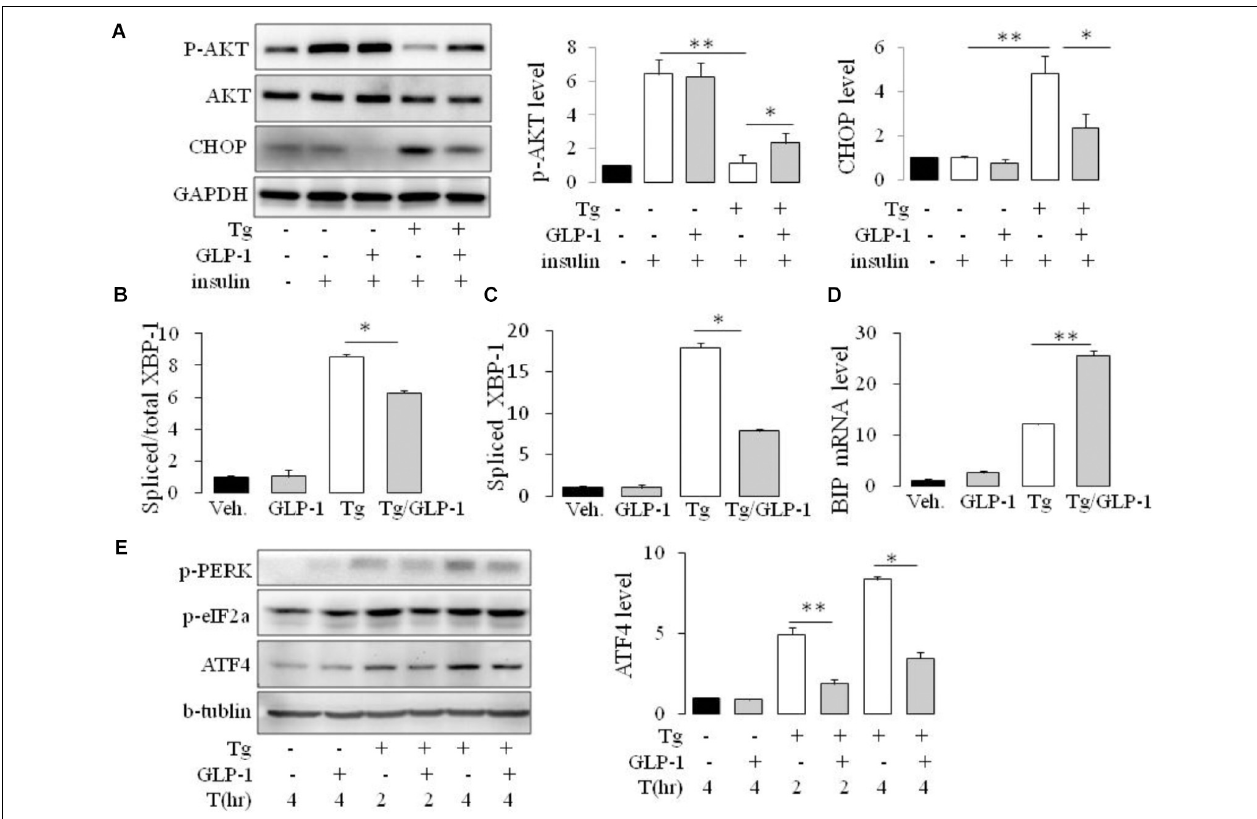
FIGURE 2 | GLP-1 attenuated insulin resistance (IR) and regulated both PERK and IRE1/XBP-1 arm of the UPR in mouse adipose cell line. 3T3-L1 preadipocytes were induced to differentiate into mature adipocytes. (A) The differentiated adipocytes were fasted for 6 h in low-glucose DMEM media with 0.2% BSA (fasting media) and then were treated with vehicle alone or thapsigargin (Tg) in the absence or presence of 50 nM GLP-1 in fasting media for 16 h. The cells were then stimulated with insulin (100 nM) in fasting media for 10 min. (B–D) The differentiated adipocytes were fasted for 16 h in fasting media and then were treated with vehicle alone or thapsigargin (Tg) in the absence or presence of 50 nM GLP-1 in fating media for 9 h (B–D) or for 2–4 h (E) . Three wells of cell extracts were pooled together and were analyzed by immunoblotting for (A) phospho-AKT Ser47 (p-AKT), total AKT and CHOP, (E) ATF-4, P(Ser51)-eIF2a and P(Thr980)-PERK, or by quantitative PCR for (B,C) total and spliced XBP-1 and (D) BIP. GAPDH or b-tublin was used as internal control. Data represent means ± SE of four (A) or three (B–E) independent experiments. ∗ P < 0.05 and ∗∗ P <